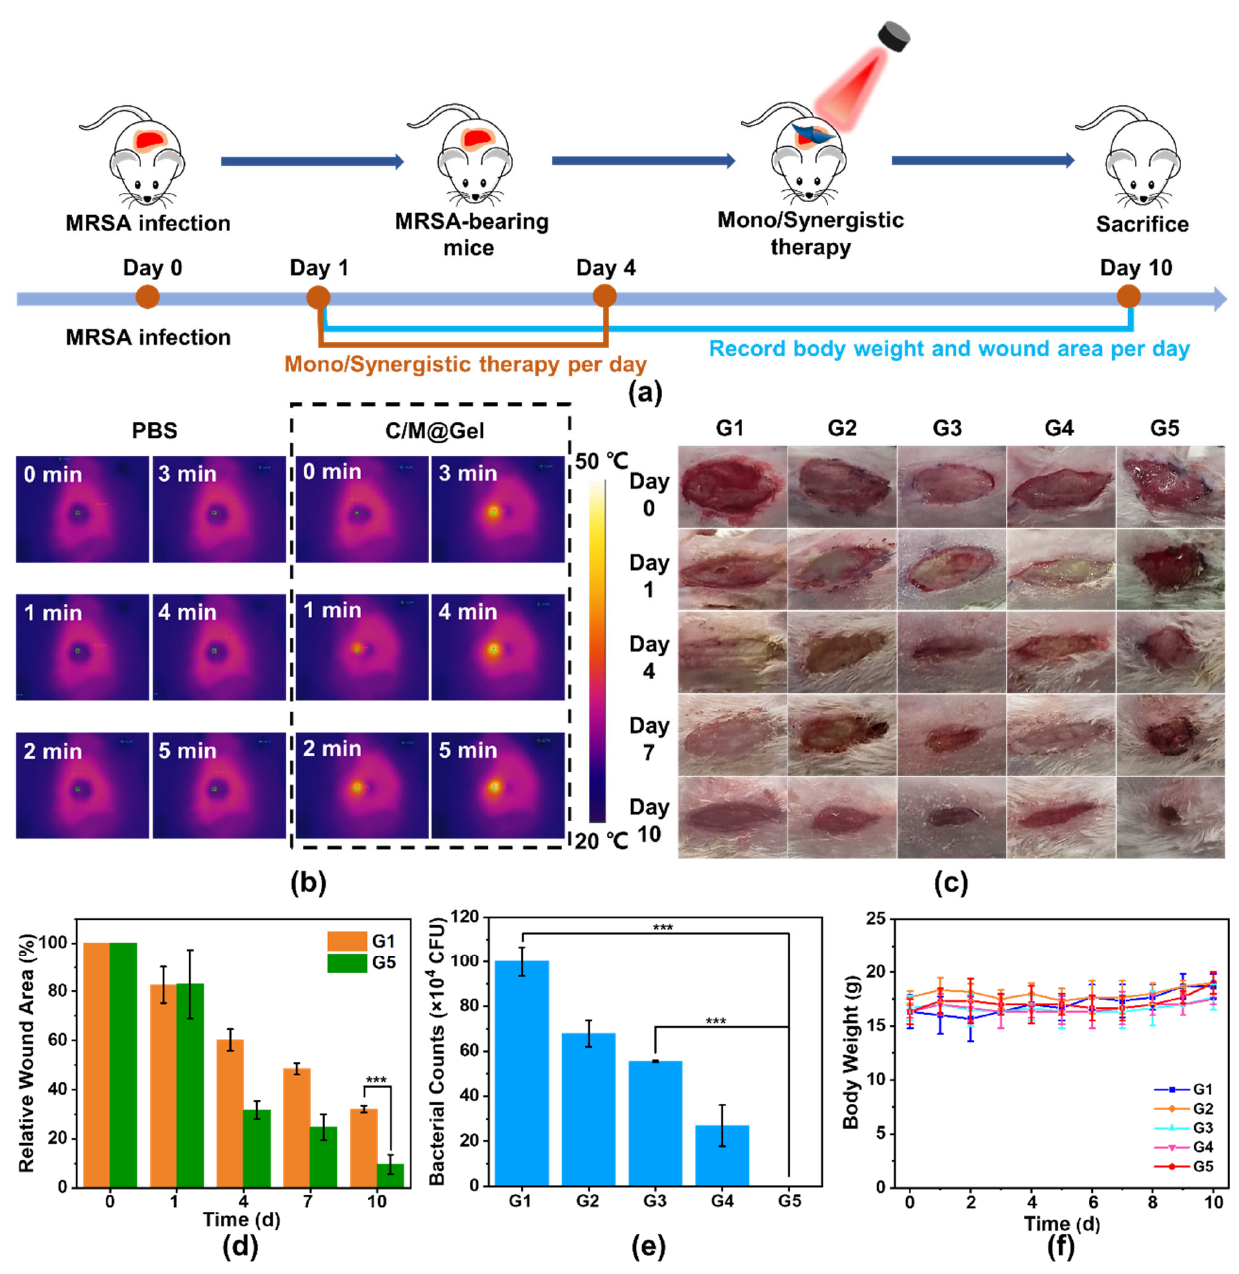
Figure 5. Antibacterial performance of mono/synergistic therapy in vivo . ( a ) Schematic description of the treatment procedure in vivo . ( b ) Temperature elevation of infected area under NIR laser at 0.8 W/cm 2 within 5 min after PBS and C/M@Gel with NIR treatments, respectively. ( c ) Represen- tative images of skin wounds during the treatment process in vivo. ( d ) Quantitative wound areas during the treatment process. ( e ) Quantitative representation of residual bacteria at the wound site after four consecutive days of mono/synergistic therapy. ( f ) Body weight records of mice along different treatment procedures. G1: PBS, G2: Gel, G3: C@Gel with NIR, G4: M@Gel, G5: